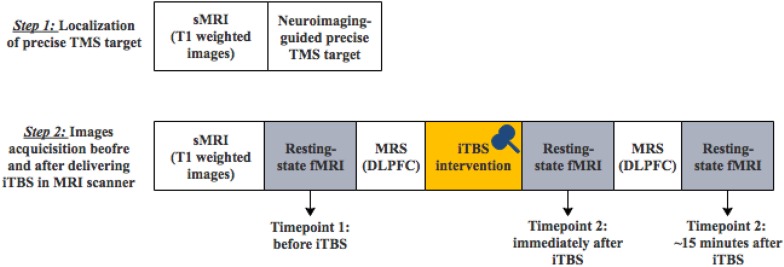
The diagram of the two-step experimental procedure (sMRI, structural MRI; TMS, transcranial magnetic stimulation; MRS, magnetic resonance spectroscopy).